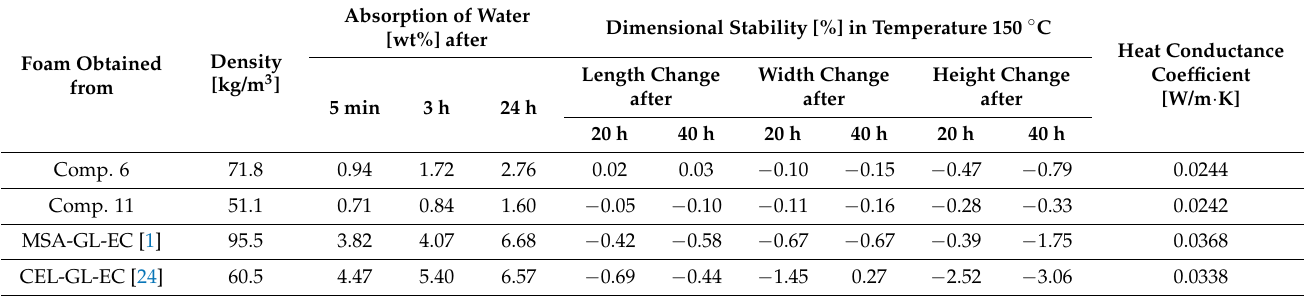
Table 6. Some properties of foams.